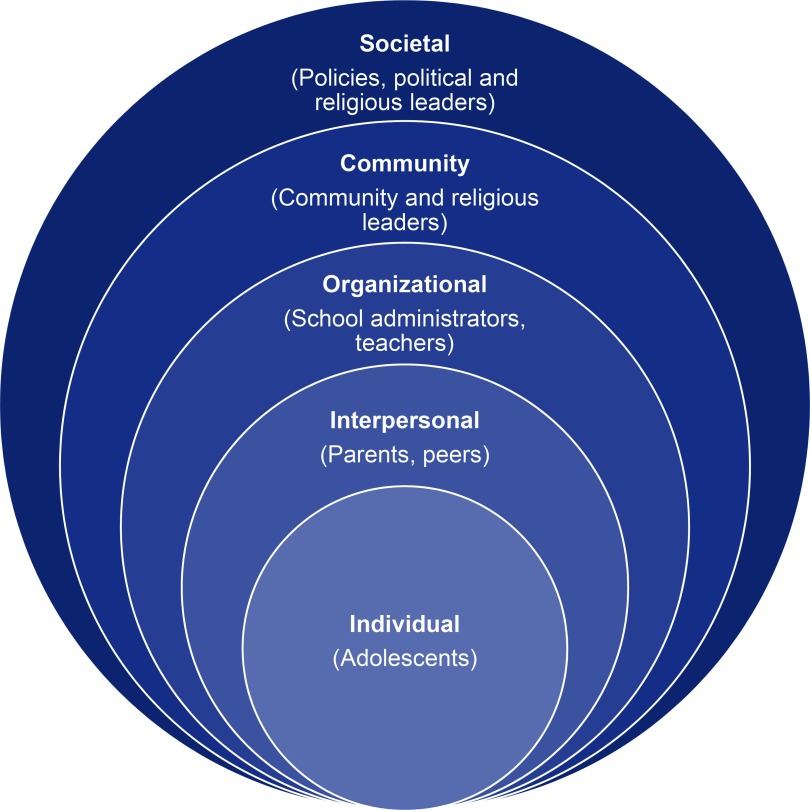
Ecological Framework: Levels of Adolescents' Influences